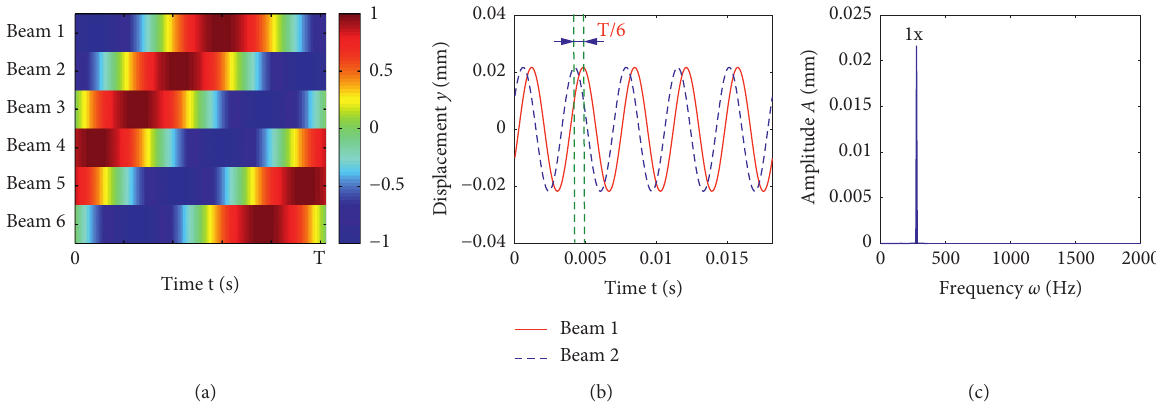
Figure 14: The response of beam root with respect to case 1 ( Ω � 200rad/s, F � 25N, ω � 300Hz): (a) response of beam 1 to beam 6, (b) response curve of beams 1 and 2, and (c) spectrum plot of beam 1.